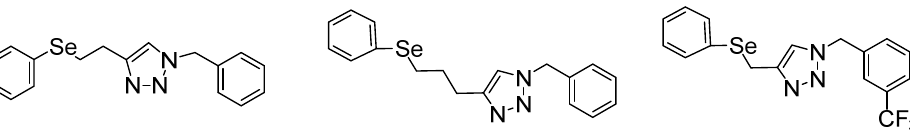
Figure 9. The organotriazoles studied by Soares et al. In relationship to H 2 S signaling, persulfides and selenosulfides and the R–SeSH motif containing compounds were importantly produced, studied and discussed by Kang et al.